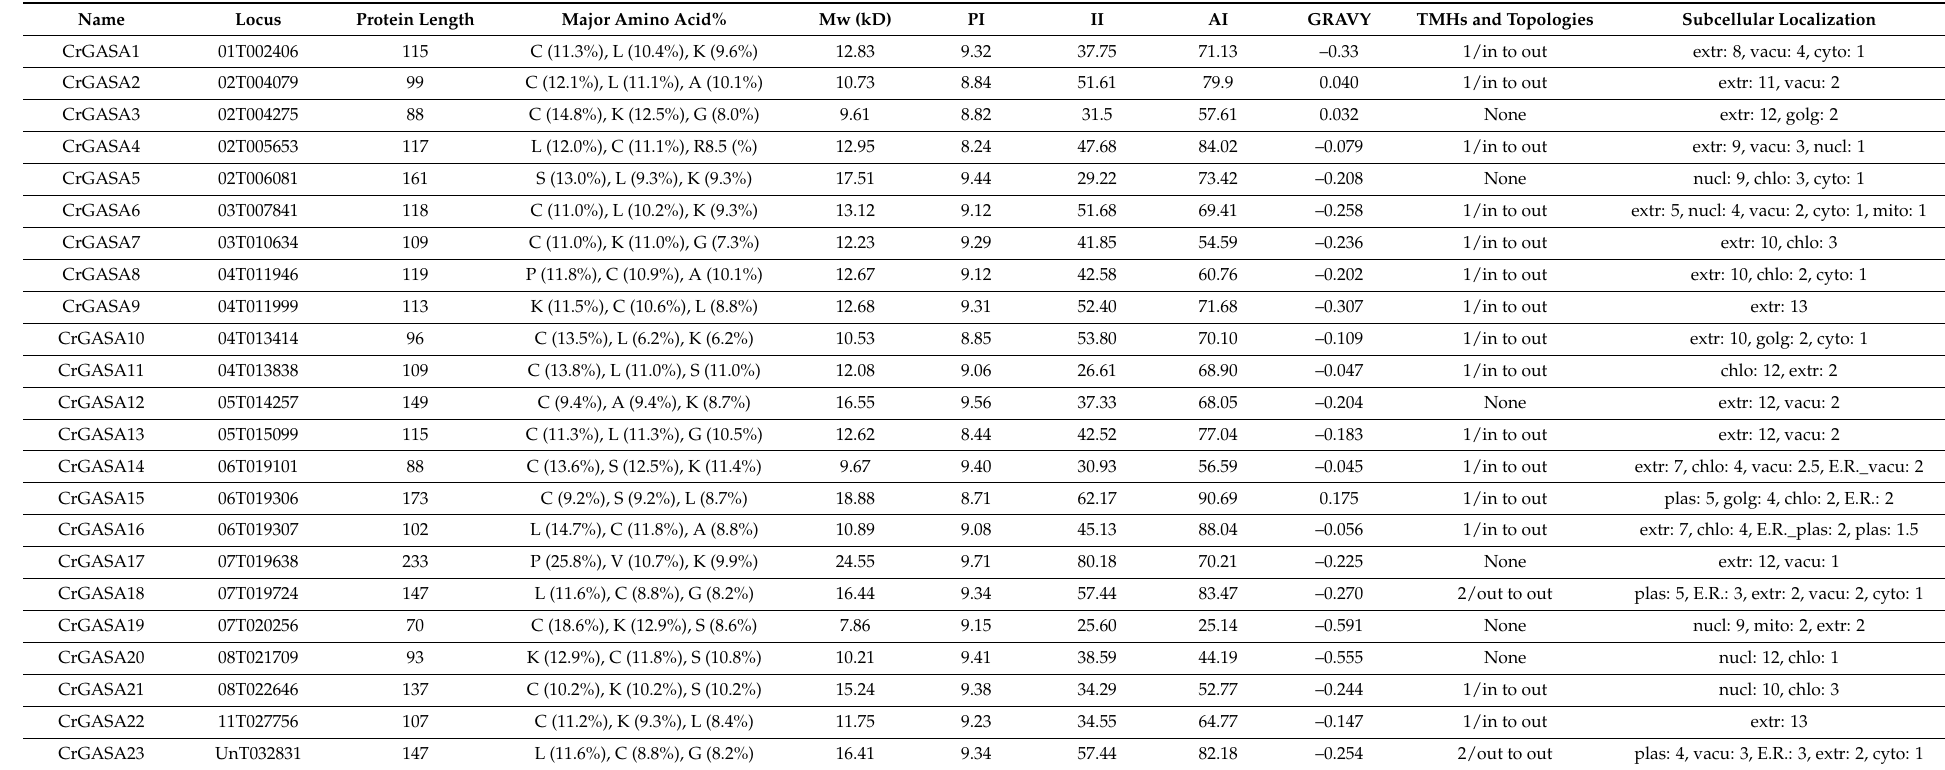
Table 1. Nomenclature and subcellular localization of CrGASAs identified from C. rosea